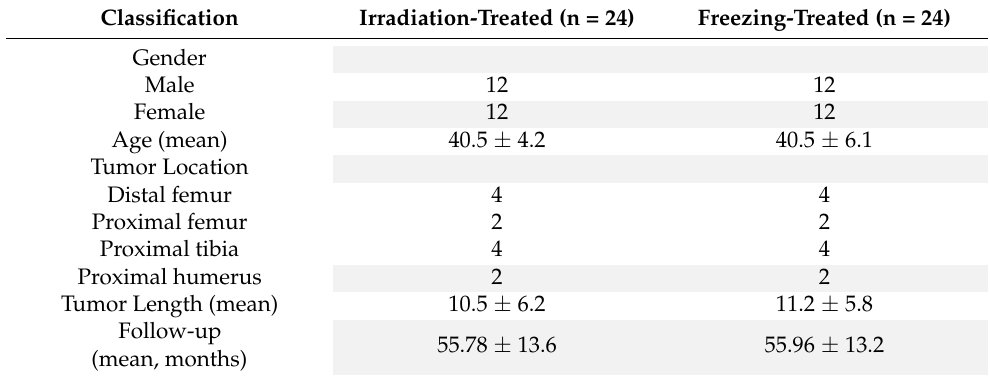
Table 1. Patient demographic